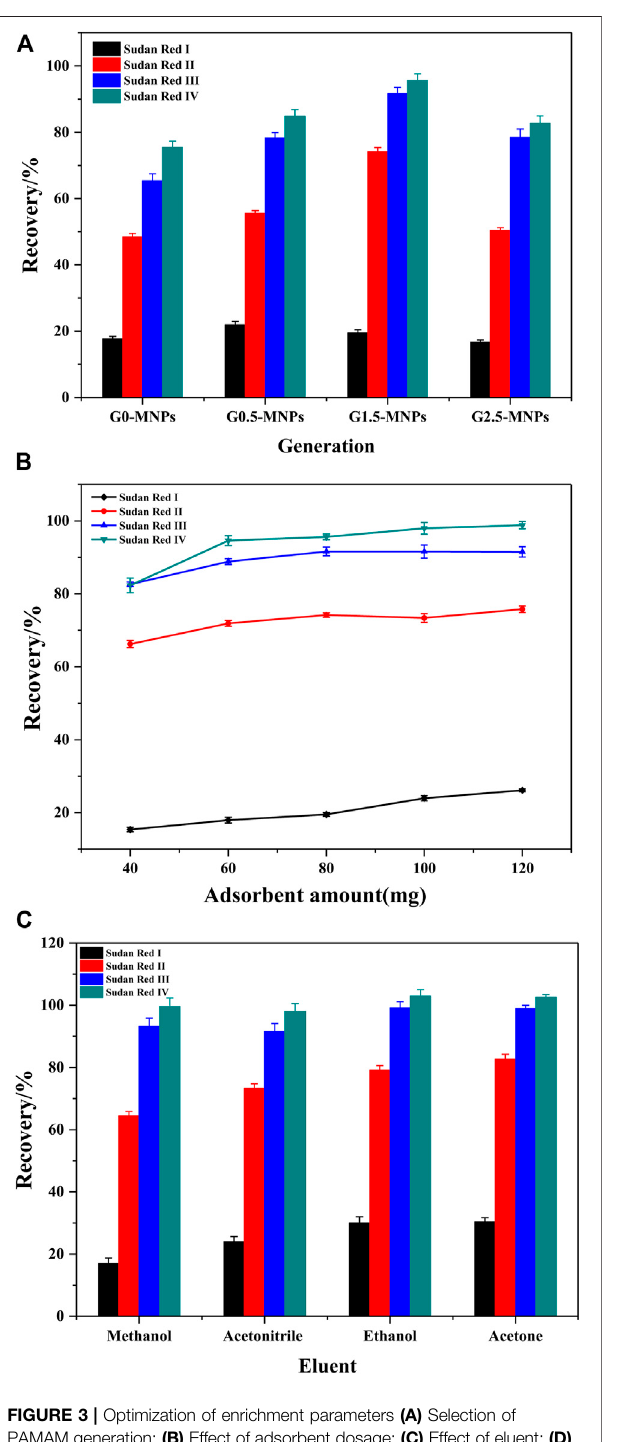
FIGURE 3 | Optimization of enrichment parameters (A) Selection of PAMAM generation; (B) Effect of adsorbent dosage; (C) Effect of eluent; (D) Effect of adsorption time; (E) Effect of eluent volume; (F) Effect of elution time Experimental conditions: spiked level of analytes, 10 μ g L − 1 ; adsorbent amount, 80 mg; eluent, acetonitrile; adsorption time, 60 min; elution volume, 6 ml; elution time, 9 min; pH, seven; ionicstrength, 0% (w/v); concentration of humic acid, 0 mg L − 1 ; sample volume, 50 ml. Each parameter was optimized with other parameters keeping constant, and the optimal value was used in the subsequent optimization process.